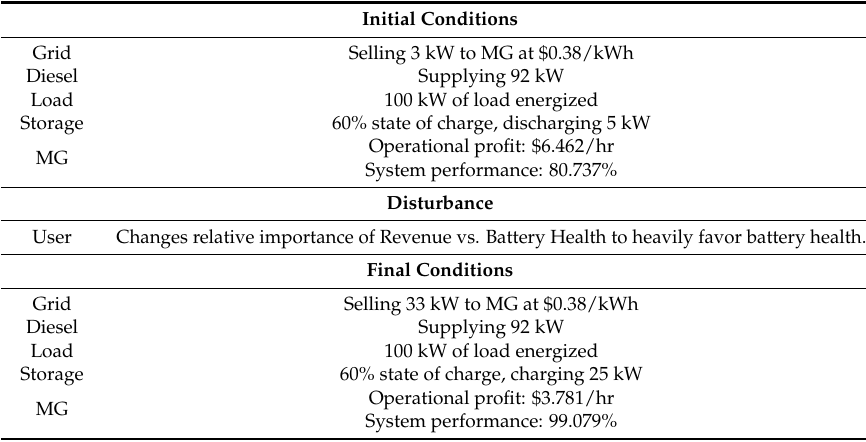
Table 5. Scenario